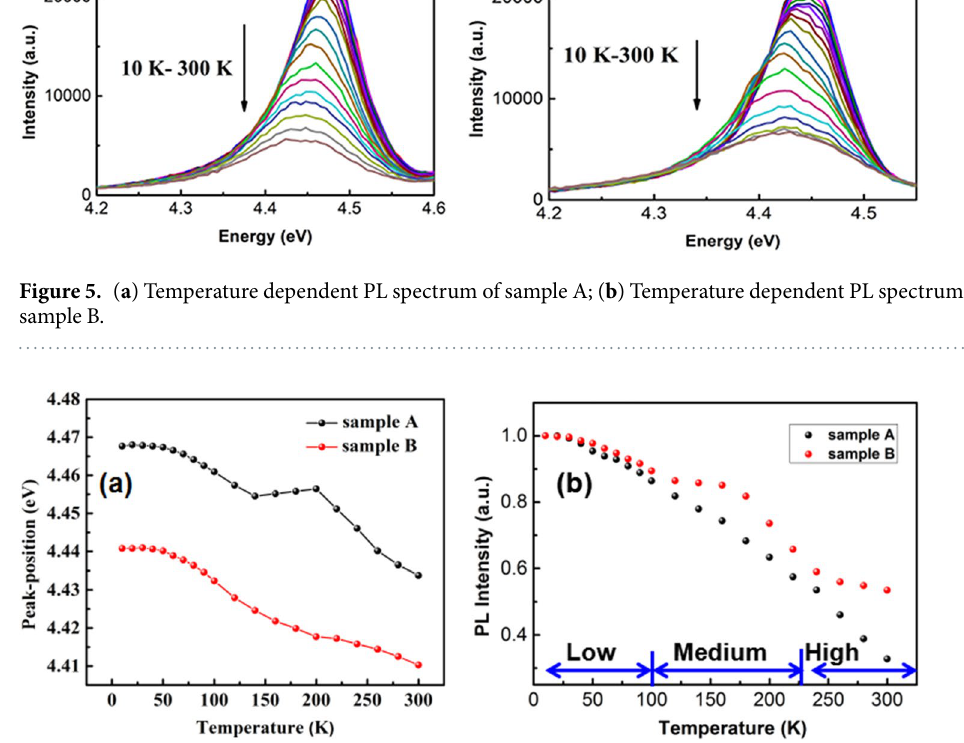
Figure 6. ( a ) Temperature dependent PL peak positions of the sample A (black) and sample B (red); ( b ) Temperature dependent integrated PL intensities of the sample A (black) and sample B